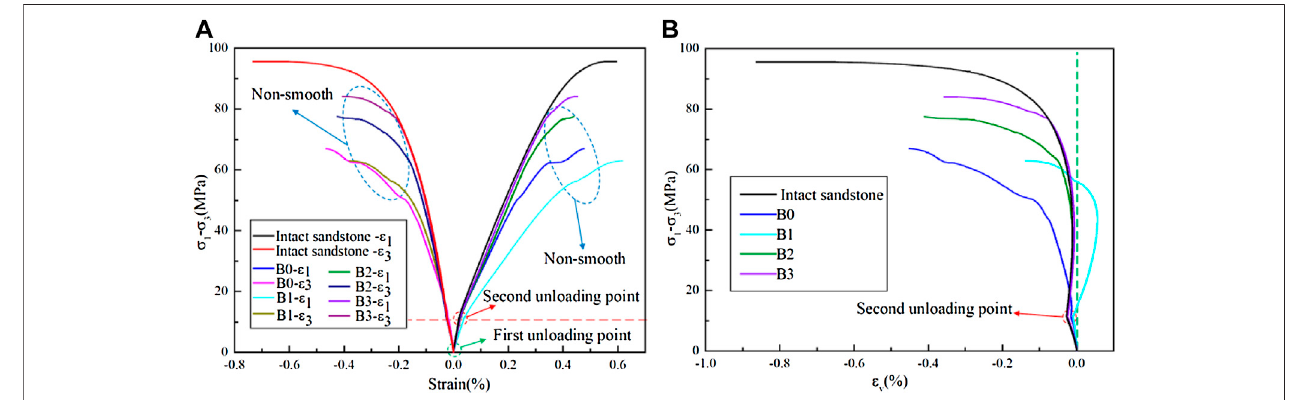
FIGURE 4 | Stress-strain curve of sandstone samples with different single-crack angles and an intact sample: (A) deviator stress vs minimum principal strain; (B) deviator stress vs volumetric strain (A2, 60 ° , 10 mm; B2, 60 ° , 15 mm; C2, 60 ° , 20 mm; D2, 60 ° , 25 mm; B0, 0 ° , 15mm; B1, 30 ° , 15 mm; B3, 90 ° , 15 mm).